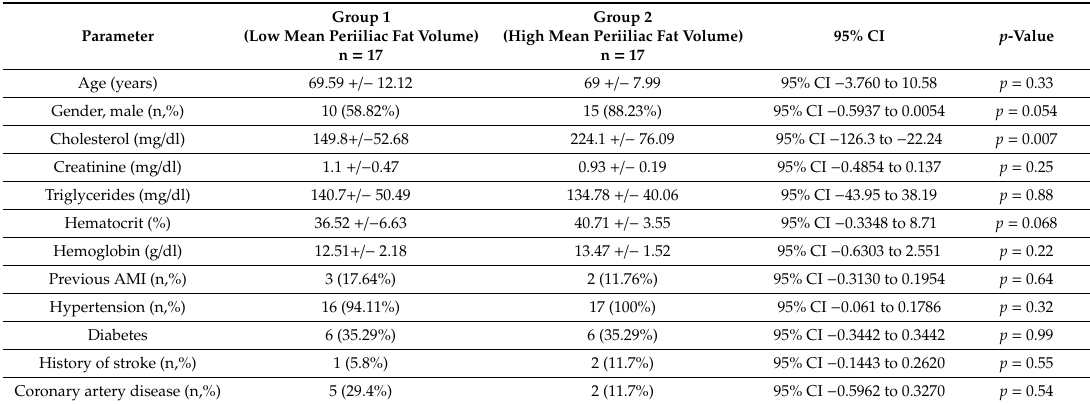
Table 1. Baseline characteristics, comorbidities and cardiovascular risk factors of the study population.